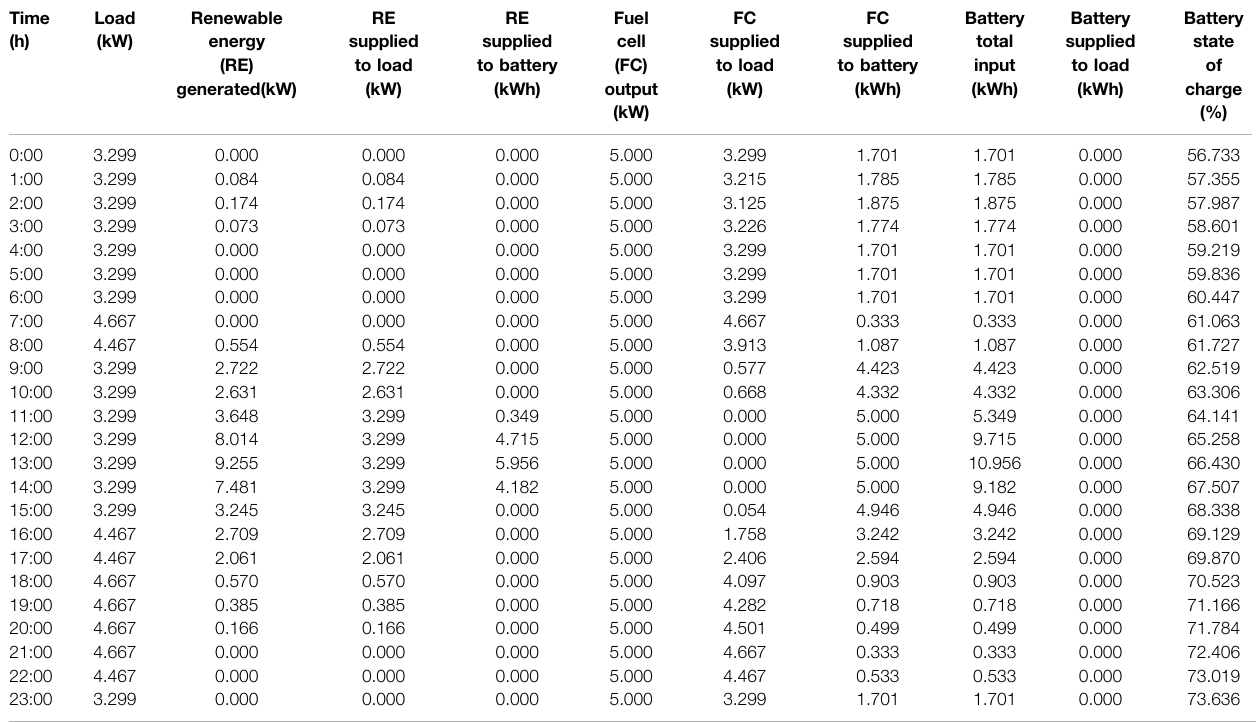
TABLE 2 | Power demand met by the integrated renewable energy system (PV and wind) in day two. Time Load (h) (kW)